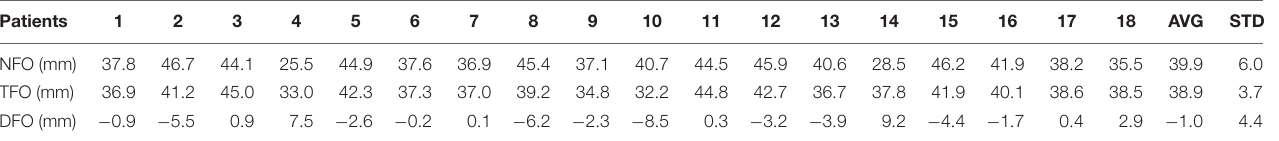
TABLE 1 | The average (AVG) and standard deviation (STD) of FO in THA and contralateral non-operated hip were illustrated during gait.